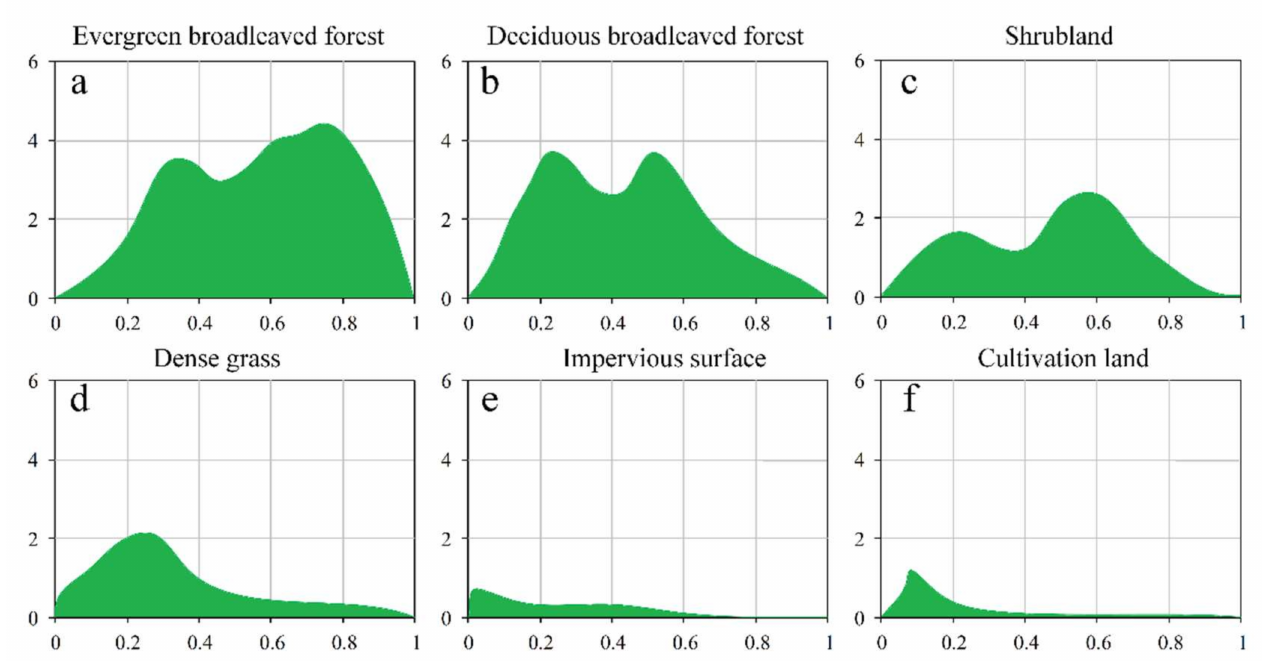
Figure 7. Simpson diversity index for the most representative types of evergreen-deciduous broad- leaved mixed forest parcels identified around plot BGS-263: ( a ) evergreen broad-leaved forest; ( b ) deciduous broad-leaved forest; ( c ) shrubland; ( d ) dense grass; ( e ) impervious surface; ( f ) cultivated land. The X-coordinate and Y-coordinate represent the Simpson index and the value related to the Simpson index,